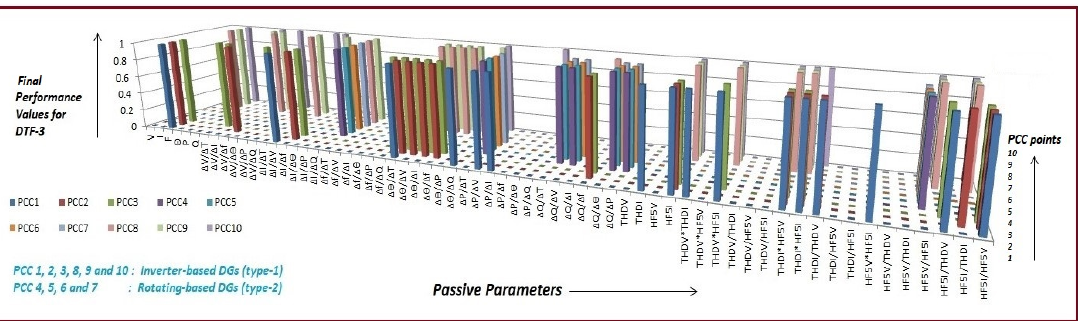
Figure 8. Effective passive parameters for DTF-3 (IEEE 37 bus system) for the LPM range of PCCs 1 to 10.